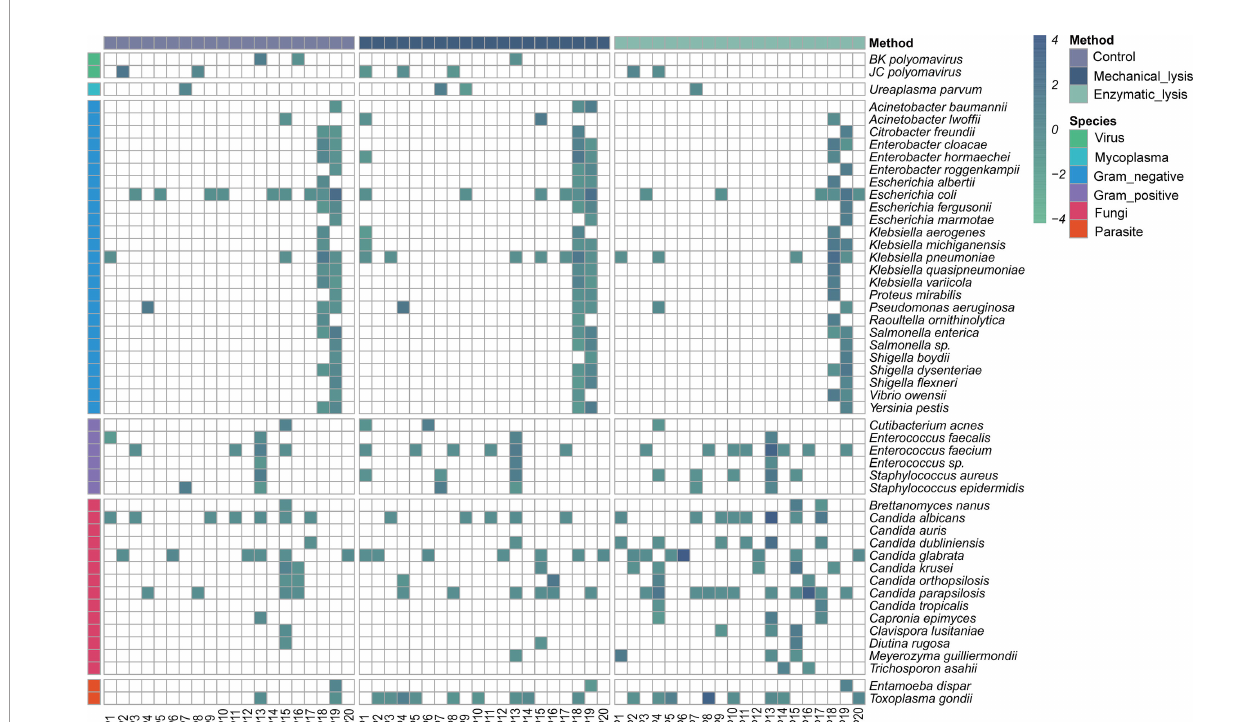
FIGURE 6 | Distribution and relative abundance of microbial pro fi le in urine samples with DNA extracted by different methods. Heatmap strip at the left and top are to aid in distinguishing different species types and DNA extraction methods,